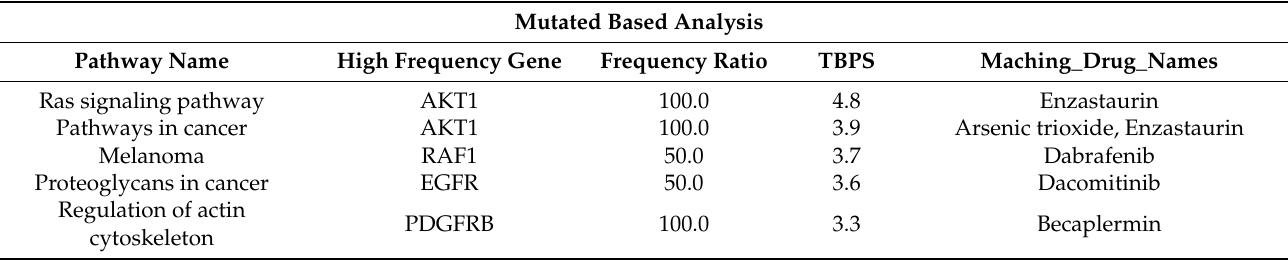
Table 5. The results of pathway analysis in the FGFR Inhibitor, nintedanib responding patient. Mutated Based Analysis